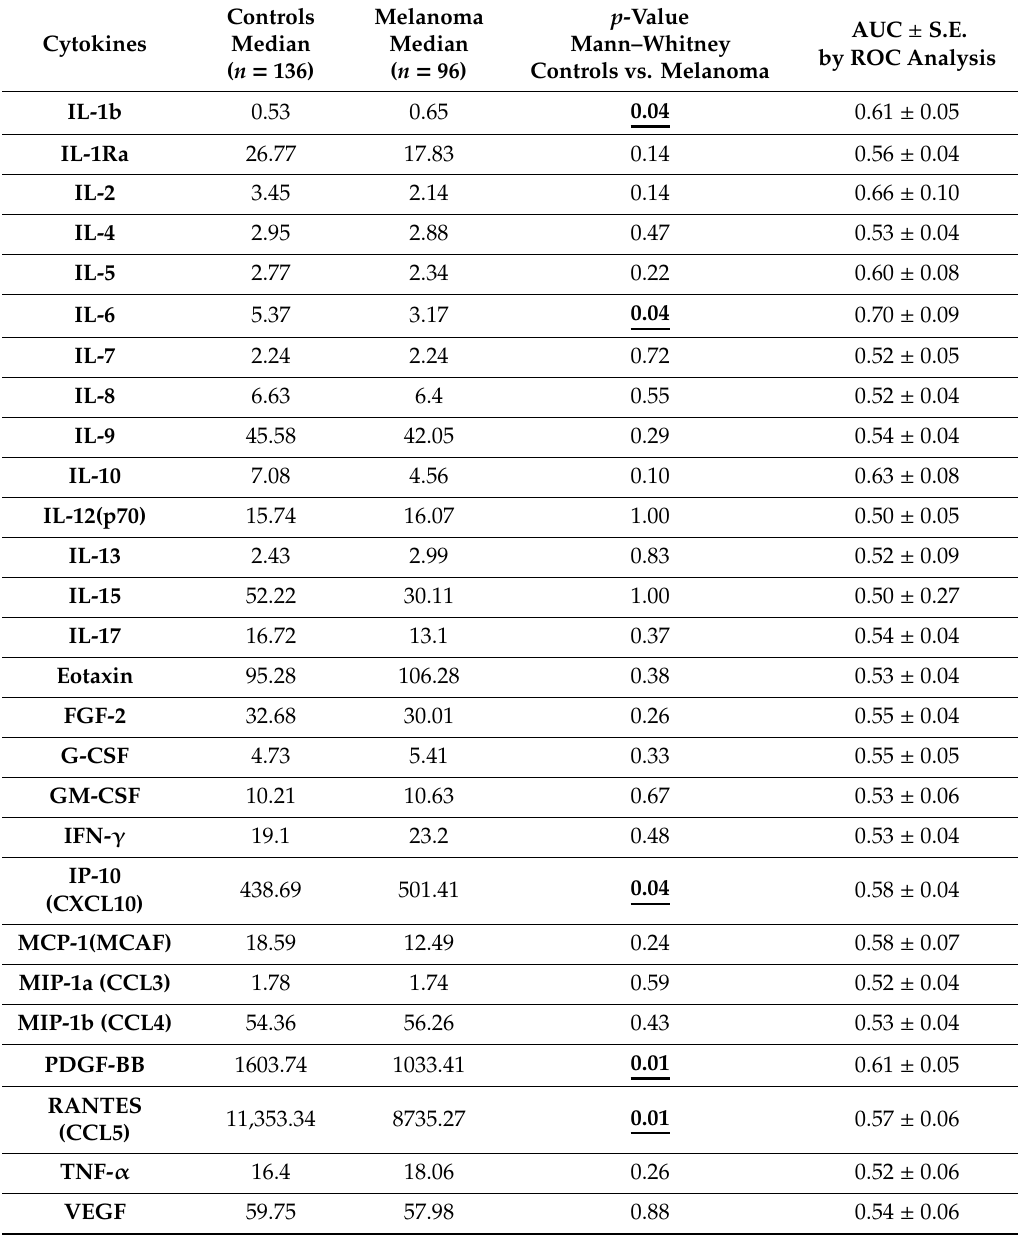
Table 2. Serum expression. Medians of the expression values of the 27 cytokines / chemokines for the control and melanoma patients. The table also reports the significance of the di ff erences according to Mann–Whitney analyses. For p -values < 0.05, the null hypothesis that the control and melanoma patients have the same median should be rejected (significant values reported in bold and are underlined); i.e., a p < 0.05 indicates a significant di ff erence. Moreover, the table reports the classification performances as the AUC values from the ROC